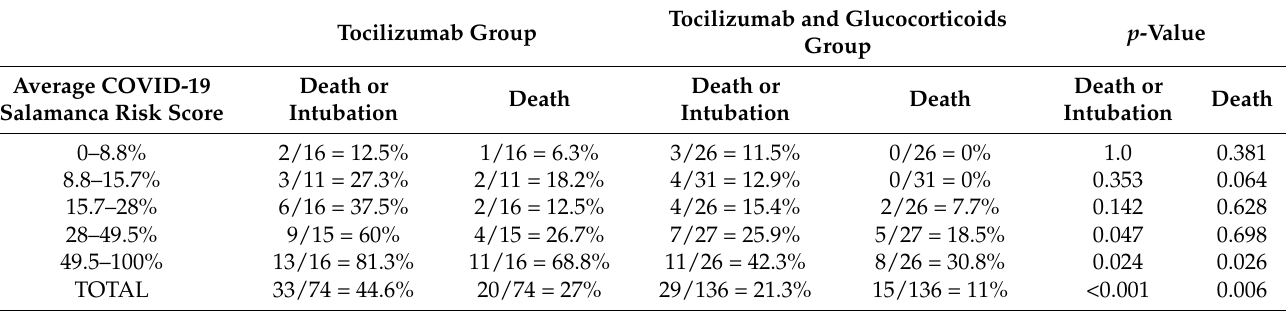
Table 3. Mortality and severity for each treatment group by risk score